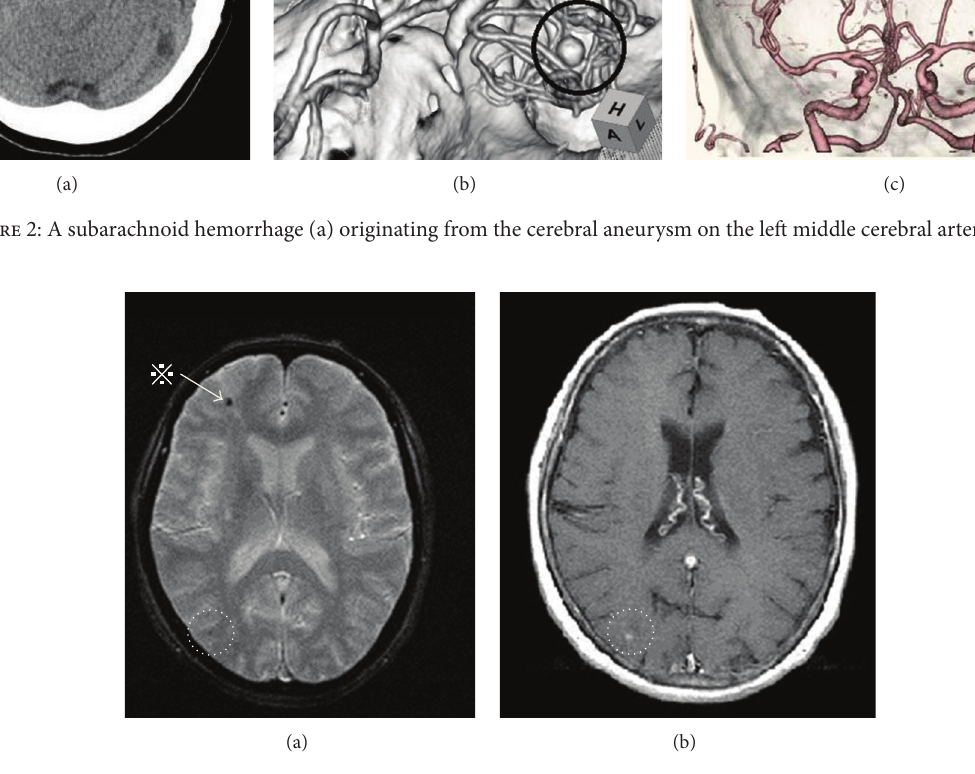
Figure 3: Black dots on T2 ∗ weighted brain magnetic resonance imaging (a) and the gadolinium (Gd) contrast medium enhancement effect. (b) n a black dot on the right frontal lobe does not show the enhancement effect seen at (b) (i.e., no fresh